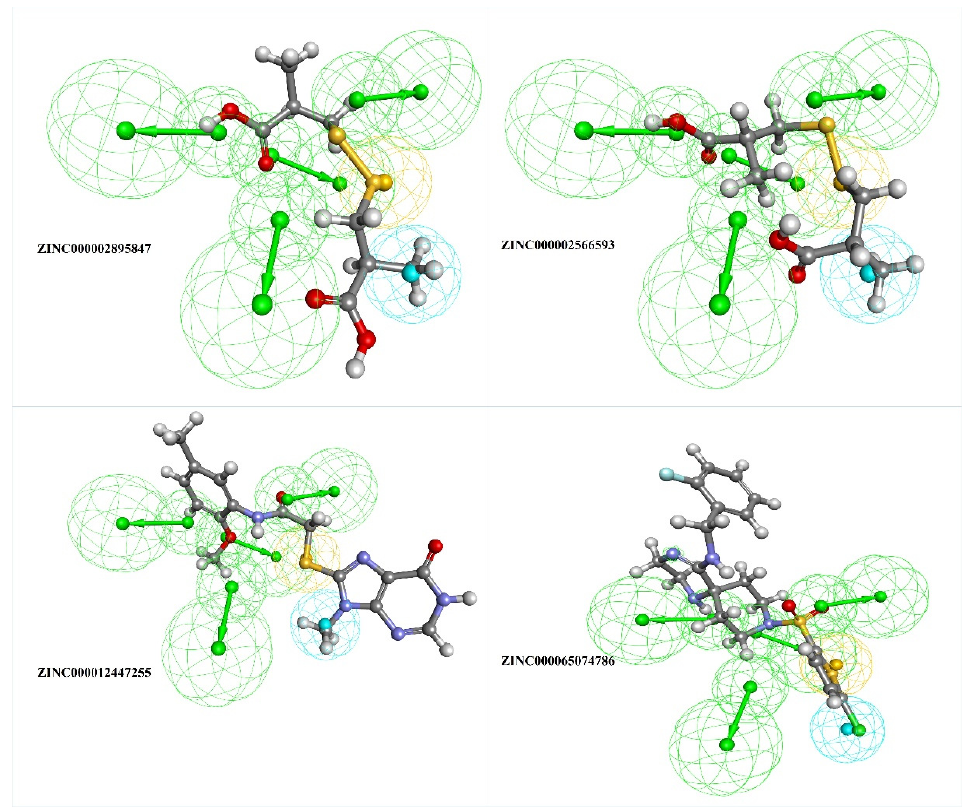
Figure 4. The top four filtered compounds aligned to the generated pharmacophore, where the green sphere indicates hydrogen bond acceptor, the blue sphere indicates hydrophobic, and the yellow sphere indicates sulfur